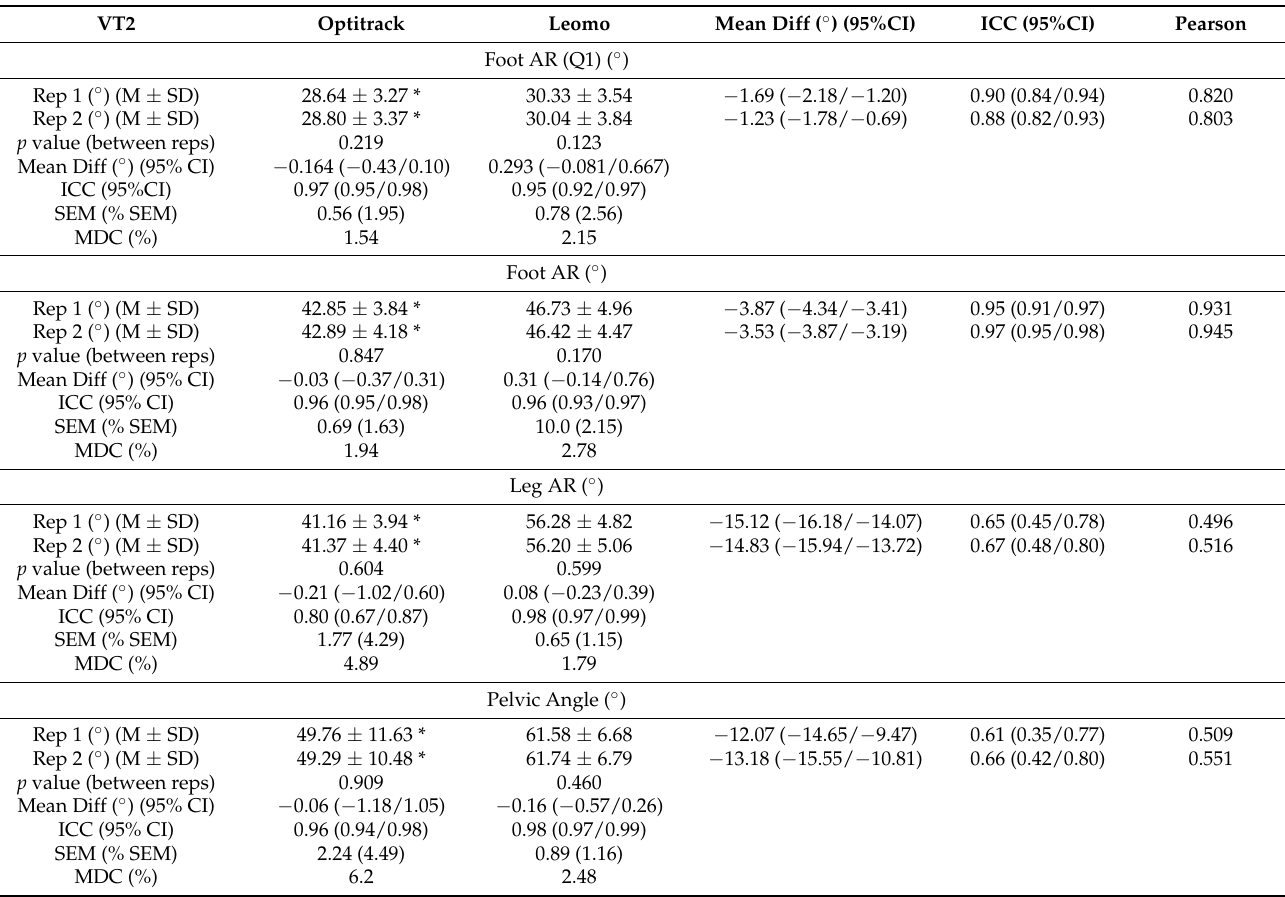
Table 4. Validity and reliability of the Leomo system with Optitrack system for assessment of angular parameters during pedaling cycle at